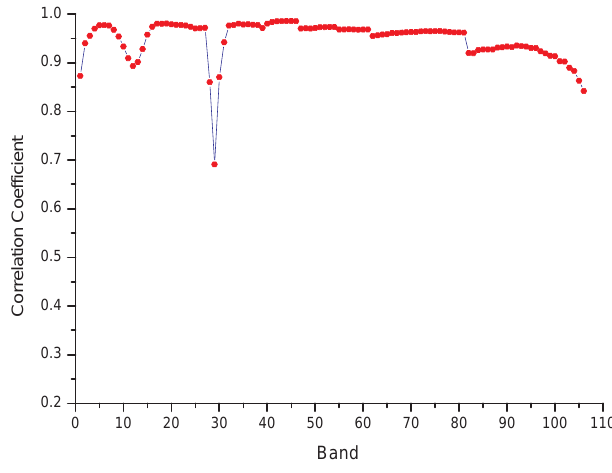
Figure 4 . Correlation coefficients between simulated and original Hyperion data of 106